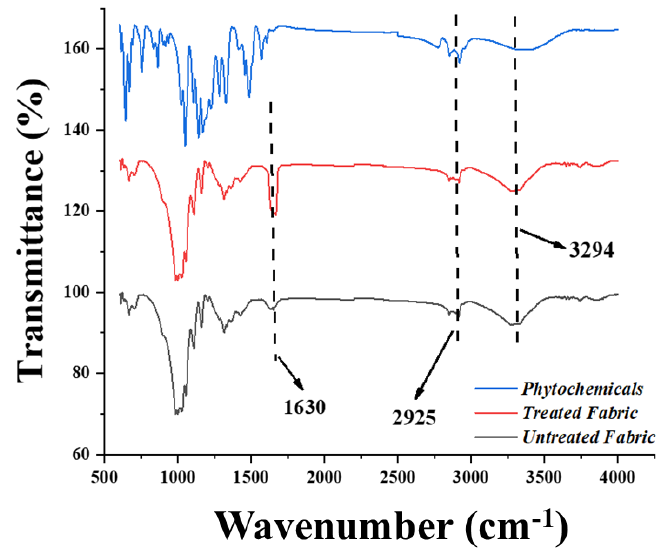
Figure 6. FTIR spectra of untreated cotton, cotton treated with citric acid, and cotton treated with phytochemicals. Table 3. Major FTIR peaks and associated functional groups [30].